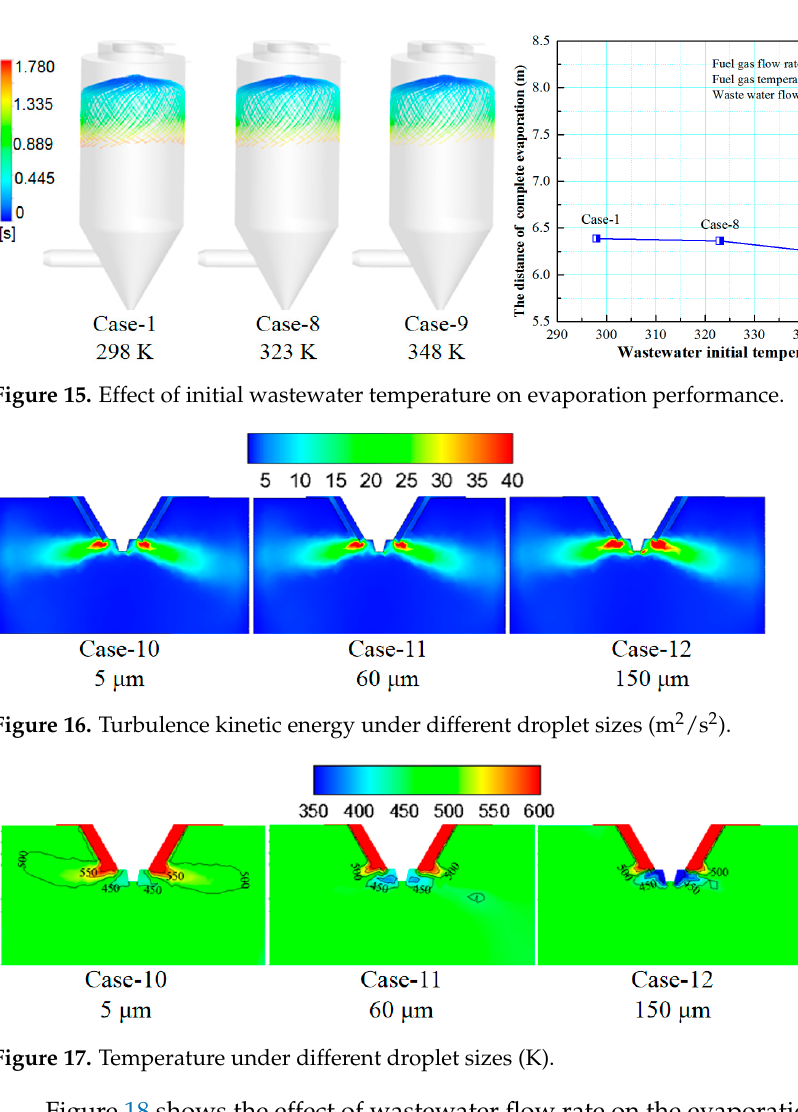
Figure 18. Effect of droplet sizes on evaporation performance.